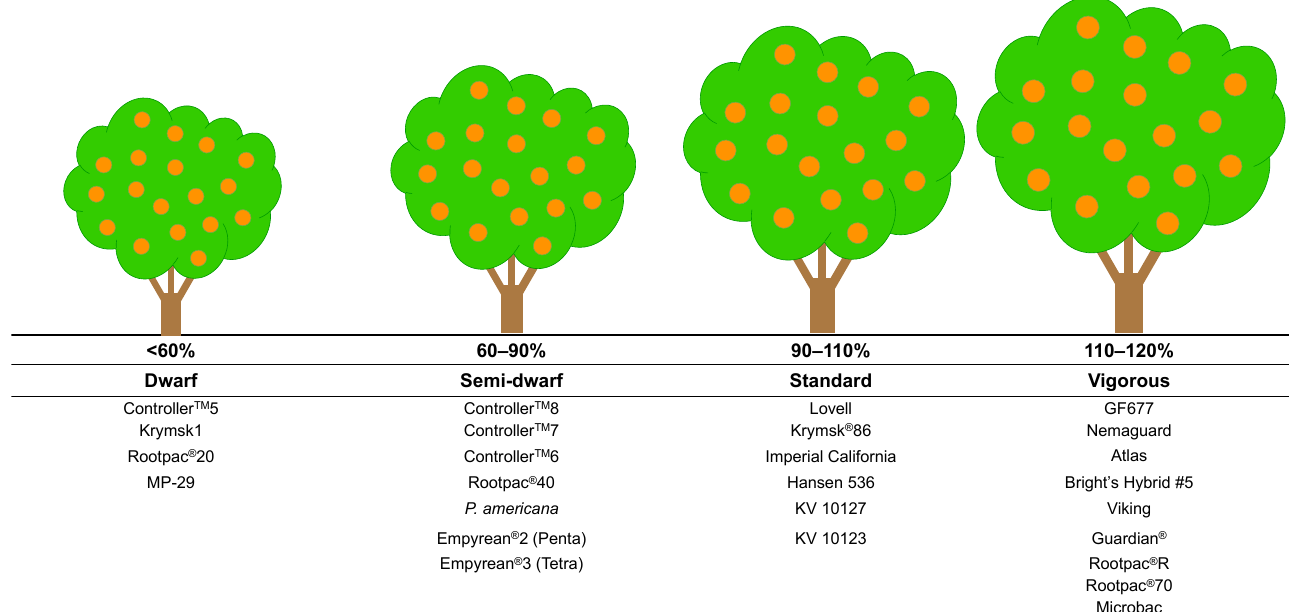
Figure 3. Peach rootstock genotypes and their vigor classification. Vigor classification is bracketed as follows: vigorous rootstocks are >110% the size of Lovell with the size estimated by trunk cross-sectional area (TCSA); standard size rootstocks are 110–90% of Lovell size; semi-dwarfing rootstocks are 60–90% of Lovell and dwarfing rootstocks are <60% the size of Lovell (vigor classification adopted from Reighard et al. [18]).